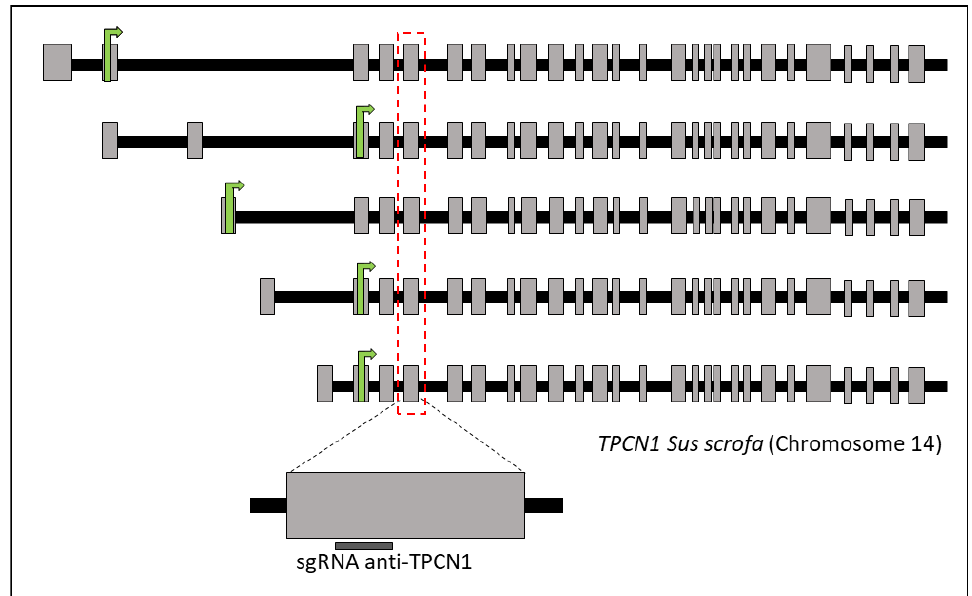
Figure 7. Schematic of TPCN1 isoforms described in Sus scrofa (NC_010456.5). Gray boxes represent exons and black boxes introns. The green arrow shows the exon containing the start codon. The red dotted line shows exon 9, where the target region is located.